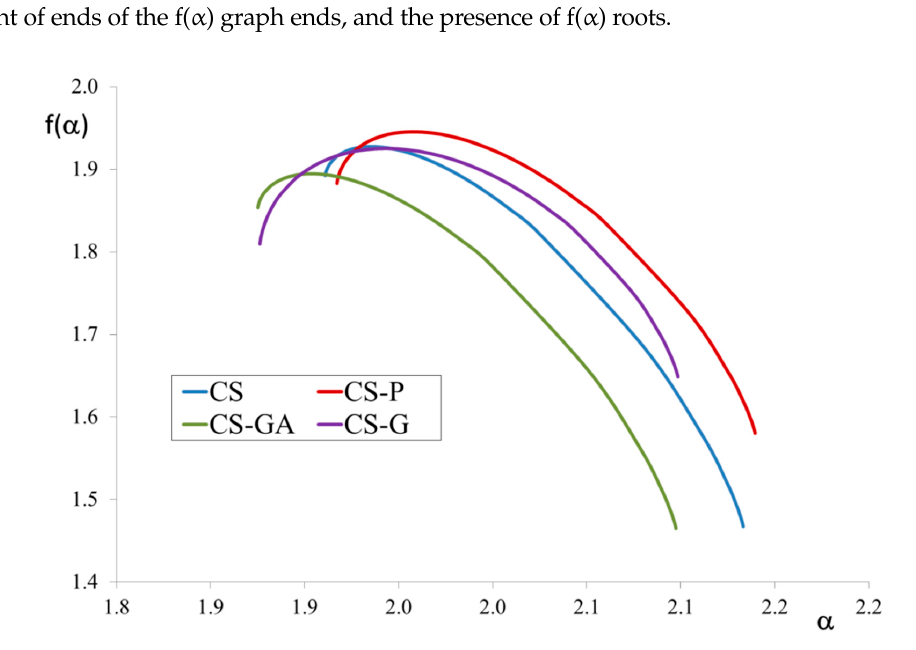
Figure 3. f( α ) spectra for alginate / chitosan microparticle membranes filled with chitosan (CS) or modified CS microparticles i.e., phosphorylated chitosan (CS ‐ P), glutaraldehyde crosslinked chitosan (CS ‐ GA), and glycidol ‐ modified chitosan (CS ‐ G).